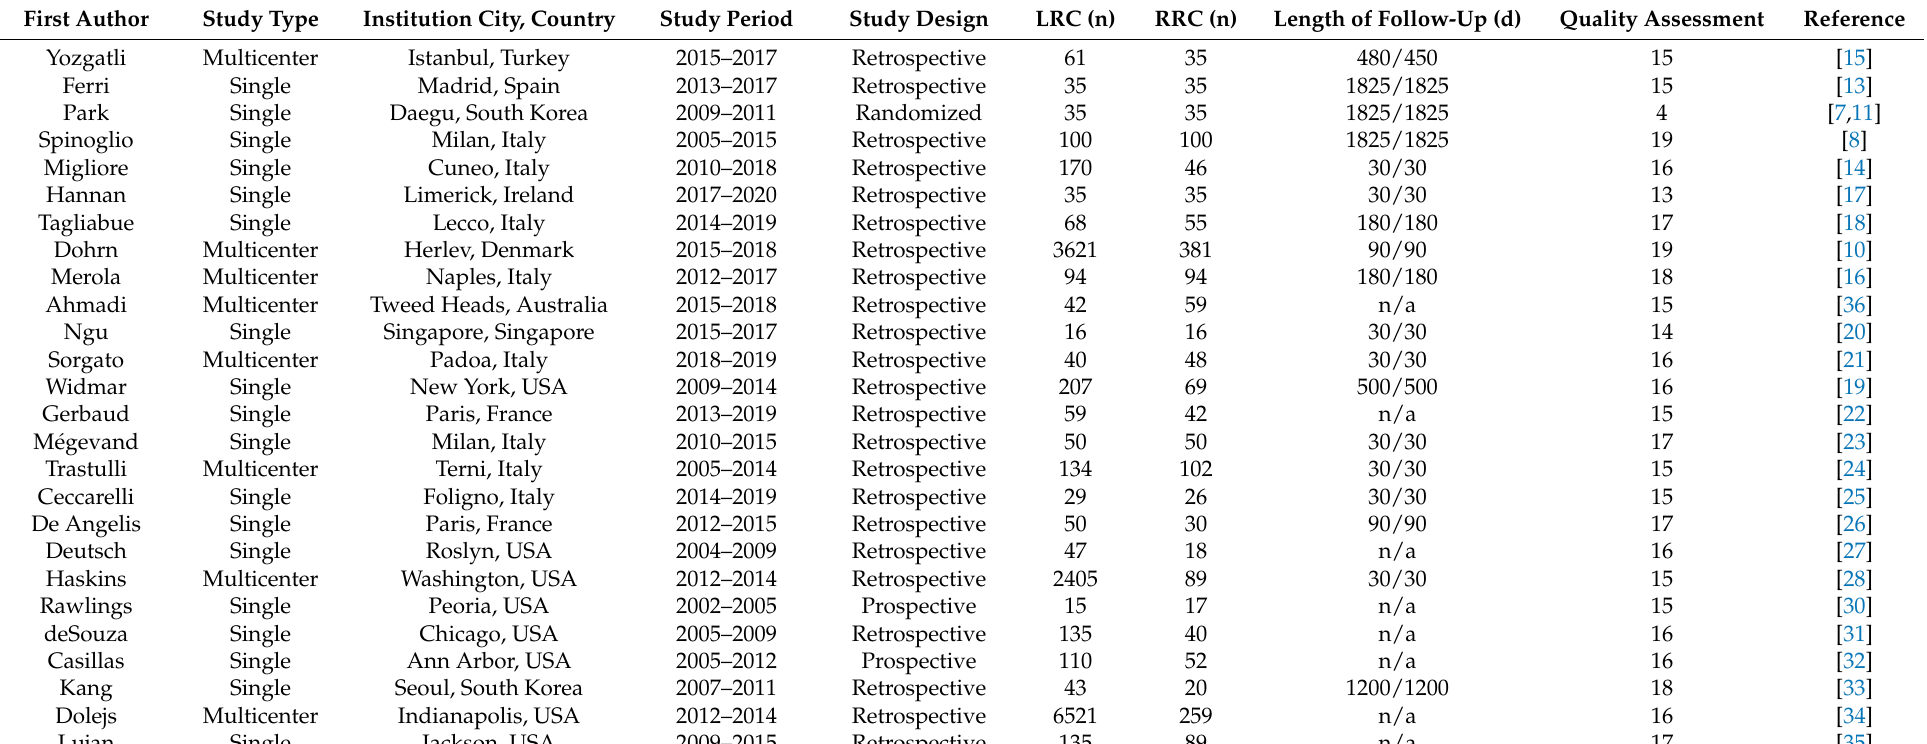
Table 1. Study details and quality